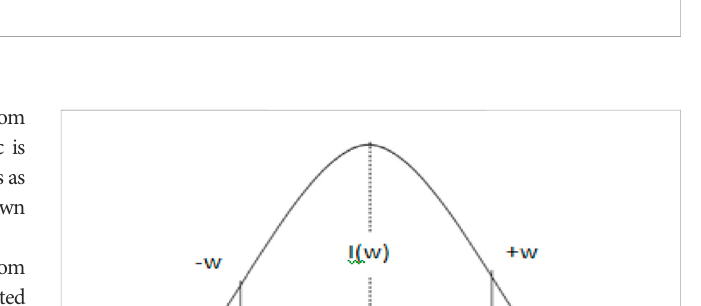
Actual image of the experimental setup with a tapered